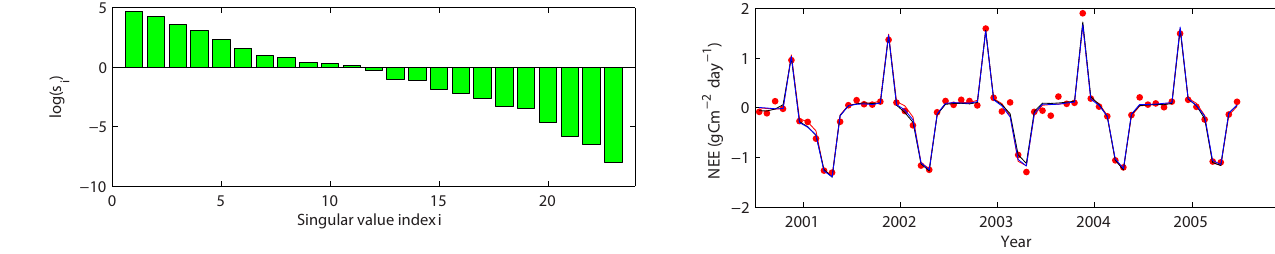
Figure 4. Singular values of the observability matrix for NEE (log scale). Figure 5. Solution of the linearised inverse problem for NEE. The red points represent the observations, the red curve is the true tra- jectory, the green curve is the trajectory obtained using the unstable solution and the blue curve is obtained using the truncated singular value decomposition (TSVD)